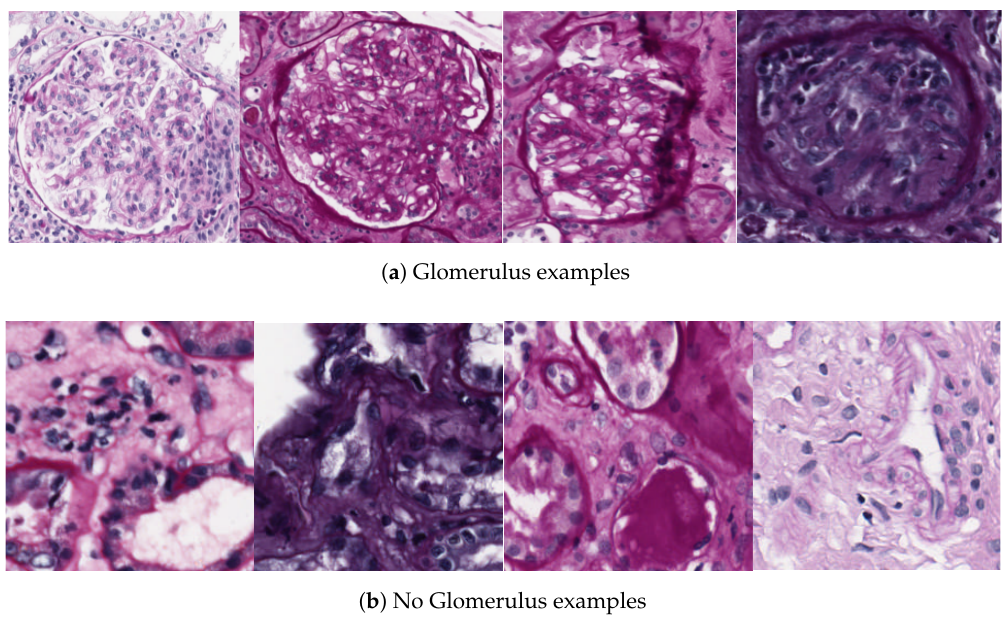
Figure 2. Examples of image patches from